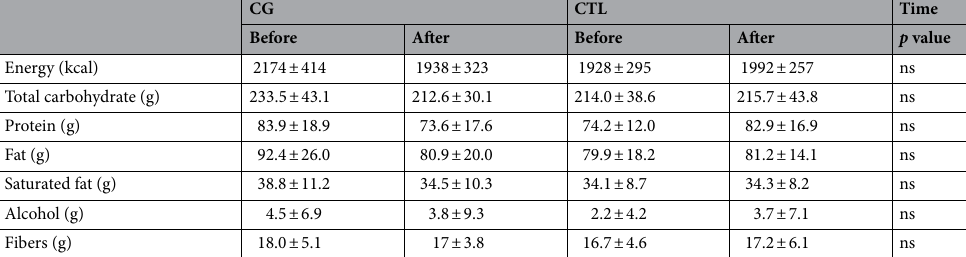
CG CTL Time Before After Before After p value Energy (kcal) 2174 ± 414 1938 ± 323 1928 ± 295 1992 ± 257 ns Total carbohydrate (g) 233.5 ± 43.1 Protein